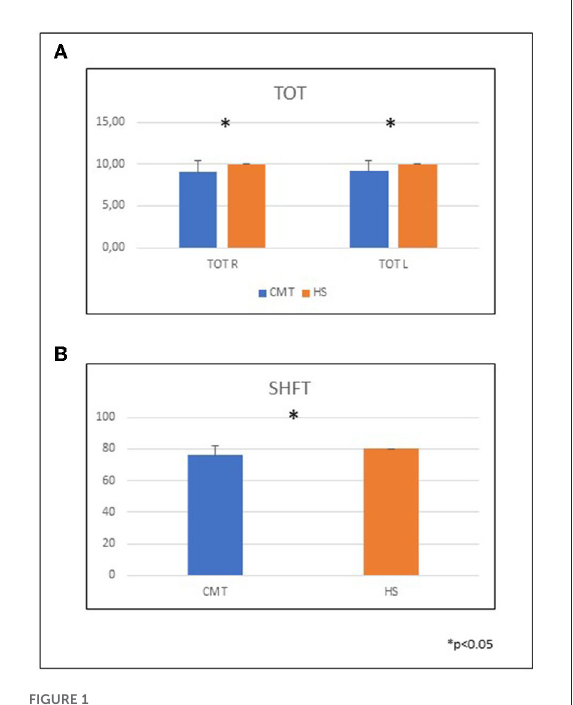
FIGURE1 CMT performances in clinical tests compared to healthy subjects. (A) Mean and SD of the TOT in the two groups. TOT DH CMT 9.05 ± 1.43; HS 10 ± 0; TOT NDH CMT 9.18 ± 1.18; HS 10 ± 0. (B) Mean and SD of the SHFT in the two groups. CMT 75.9 ± 5.9; HS 80 ± 0. TOT, thumb opposition test; SHFT, Sollerman hand function test; CMT, Charcot-Marie-Tooth;